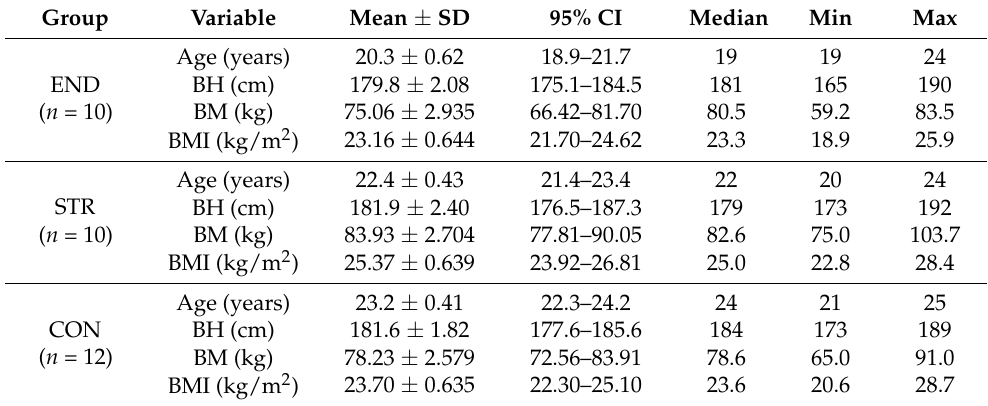
Table 1. The characteristics of the studied